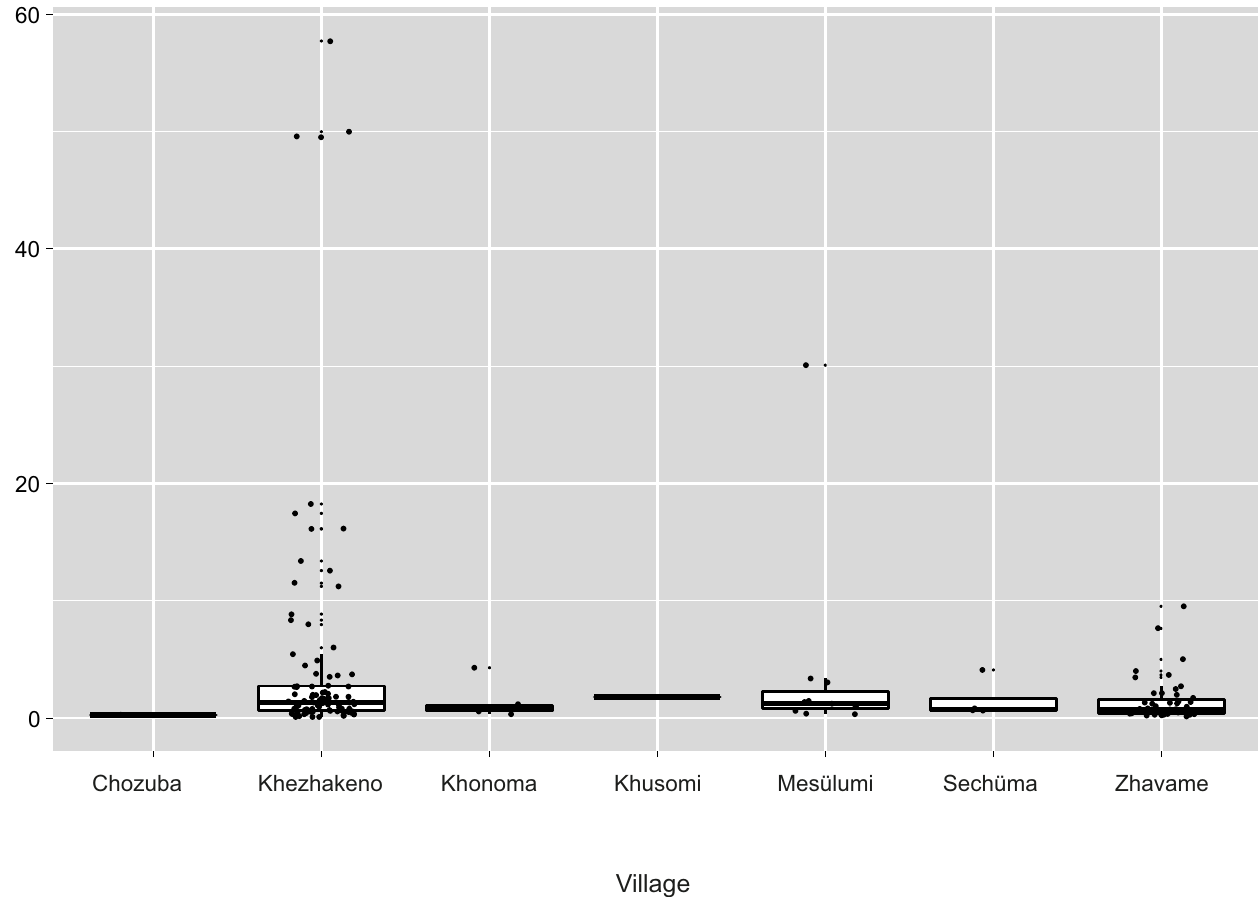
Fig 19. The size distribution (m 3 ) of single standing stones in the different villages visited in 2016. Khonoma and Sechu¨ma are Angami Naga villages; the remainder are Chakhesang Naga villages (Graphic: M. Wunderlich).